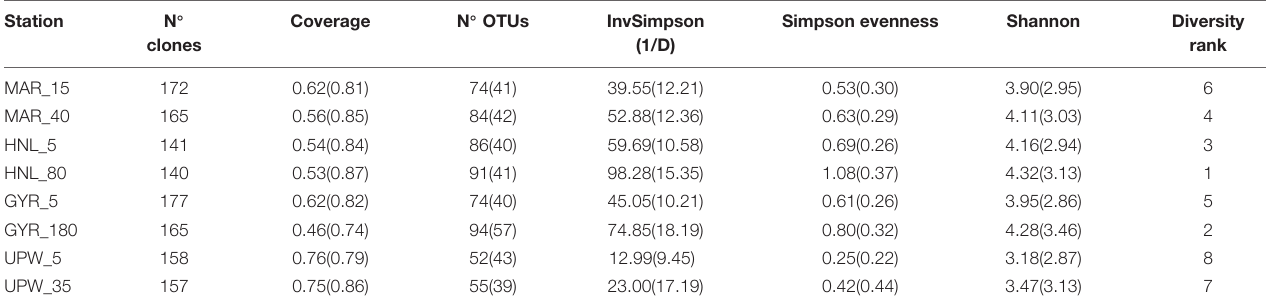
TABLE 1 | Alpha diversity for the surface and DCM libraries from the four stations MAR, HNL, GYR, and UPW normalized to 140 sequences for each library with sequence clustering into OTUs at 99% similarity. Coverage N ◦ OTUs InvSimpson Simpson evenness Shannon Diversity Station N ◦ clones (1/D)